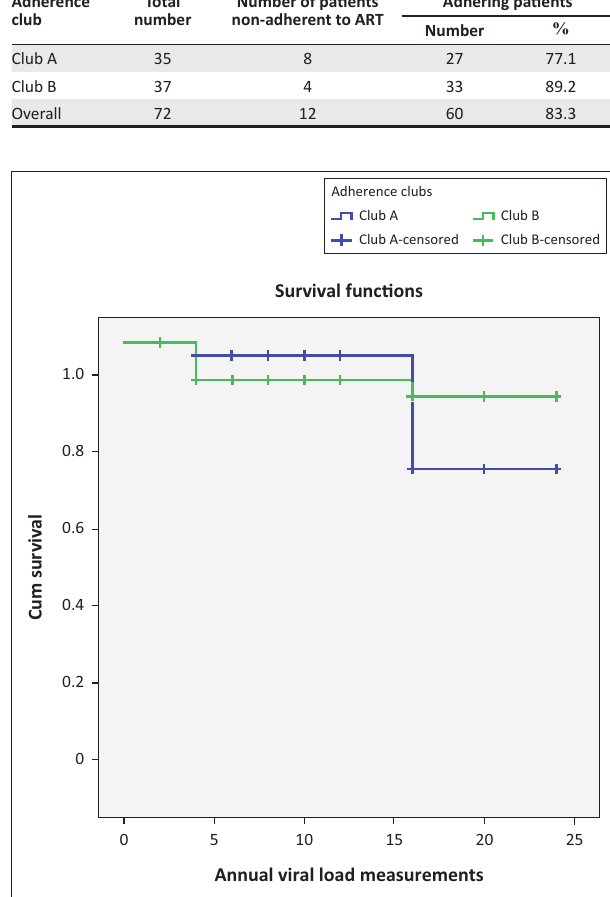
FIGURE 3: The survival distributions of the adherence behaviours of patients in the two adherence clubs at Facility Y.